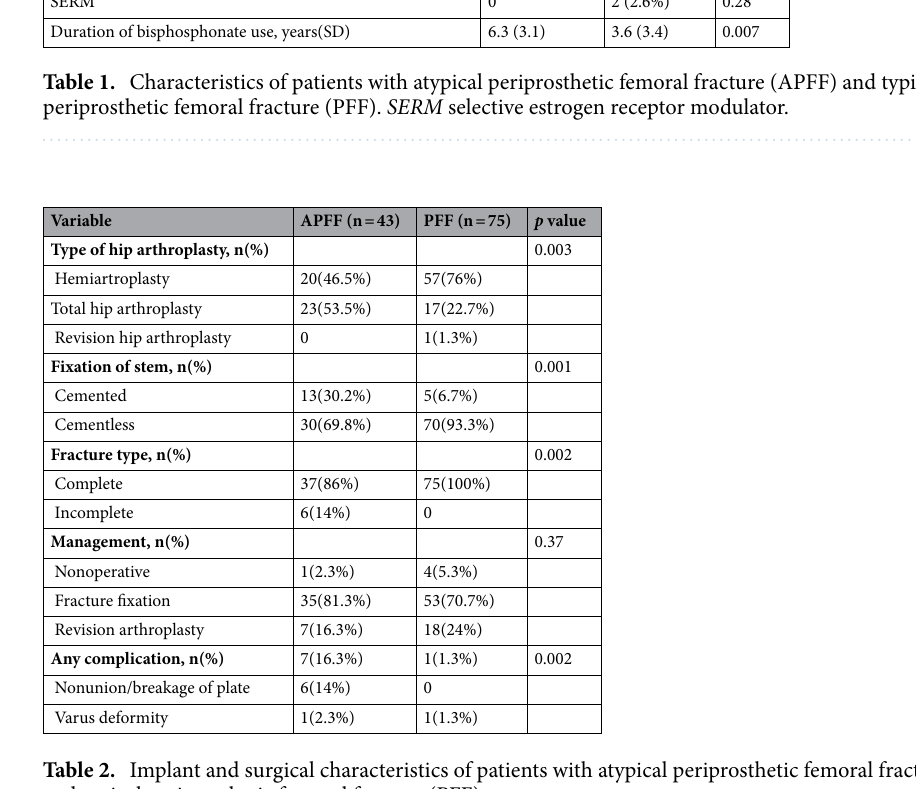
Table 2. Implant and surgical characteristics of patients with atypical periprosthetic femoral fracture (APFF) and typical periprosthetic femoral fracture (PFF).